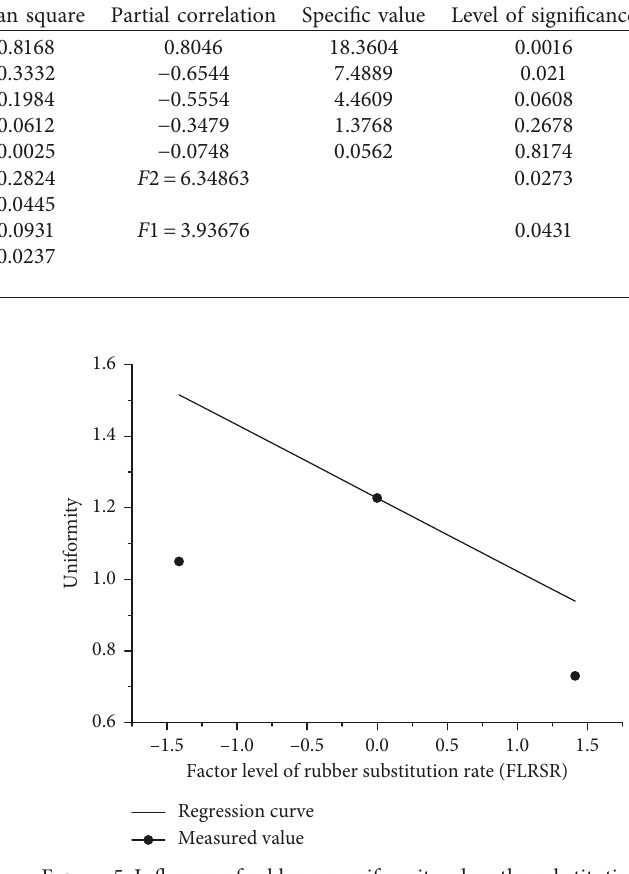
Figure 5: Influence of rubber on uniformity when the substitution rate of cellulose ether is